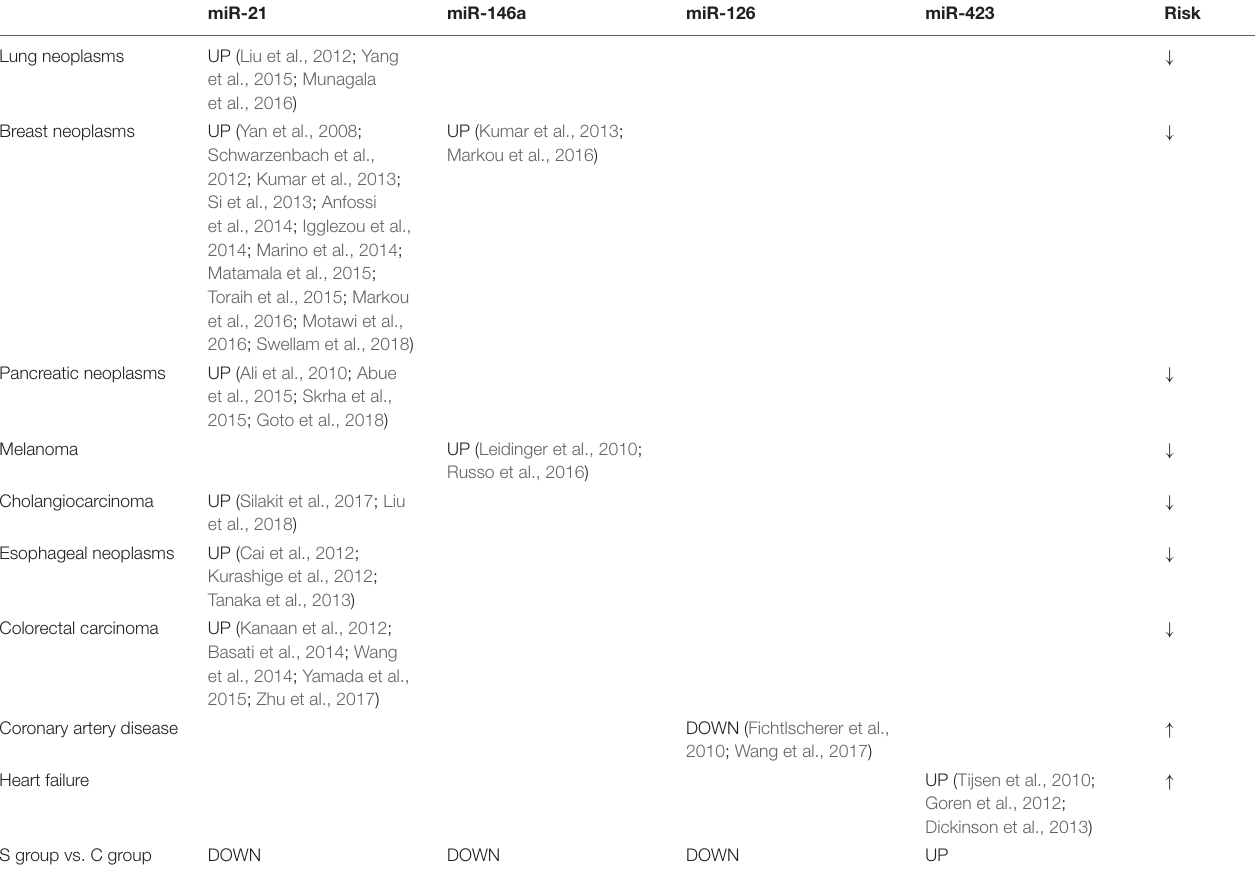
TABLE 2 | Ci-miRNA biomarkers related to certain diseases (HMDD database). miR-21